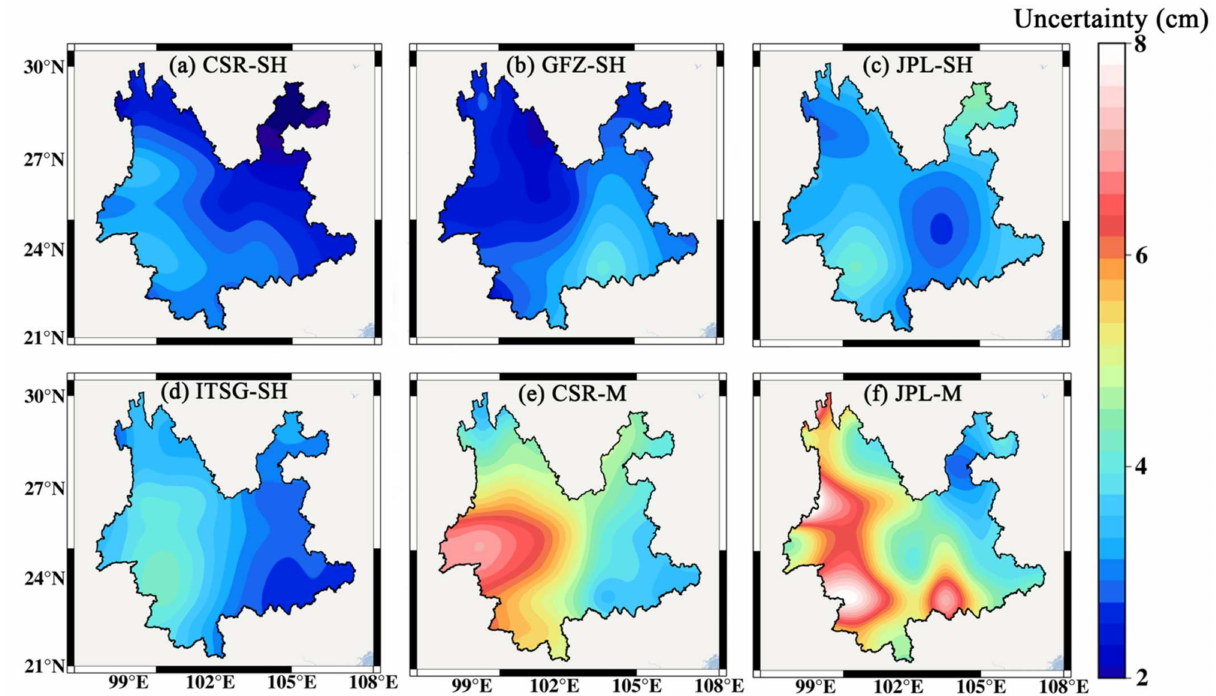
Figure 2. The spatial distribution of uncertainties of TWSC results derived from CSR-SH ( a ), GFZ-SH ( b ), JPL-SH ( c ), ITSG-SH ( d ), CSR-M ( e ) and JPL-M ( f ) solutions estimated by the GTCH method.